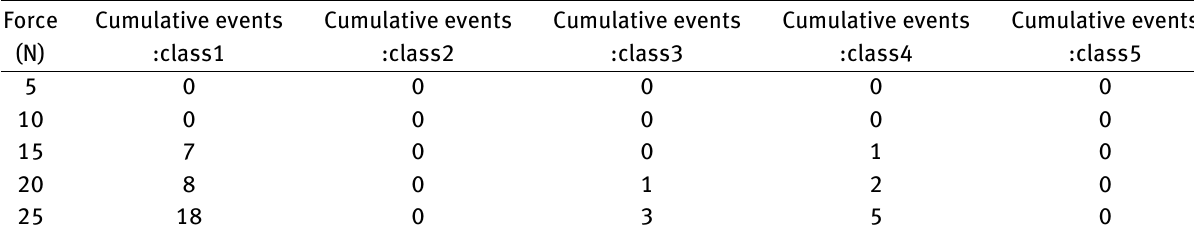
Table 8: Cumulative events for each class at the beginning of the In-situ tensile test Force Cumulative (N)